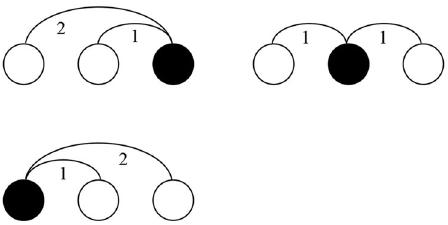
Fig. 1 Optimal sequential placement of a governor and its dependents when the length of a sentence is three. The fi gures on top left and bottom left indicate the optimal placements based on surprisal minimization and the one on top right shows the optimal placements based on